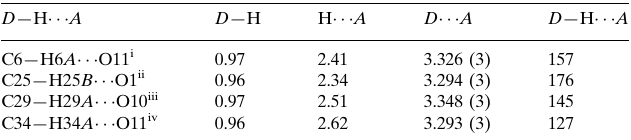
Hydrogen-bond geometry (A˚ , (cid:5)